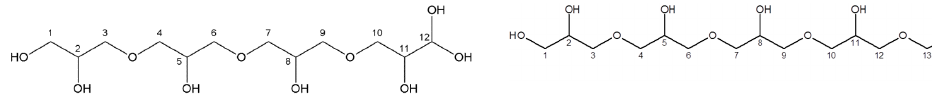
Structure no. 3. Tetraglycerol-OH (M = 330g/mol) Structure no. 4. Pentaglycerol-OH (M = 404g/mol)